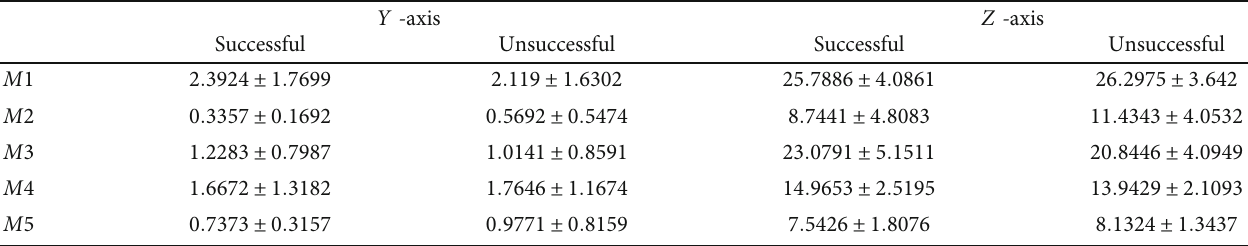
Table 6: The cumulative change of the human and bar combination barycenter of successful and failed snatch on the Y - axis and Z - axis. Y - axis